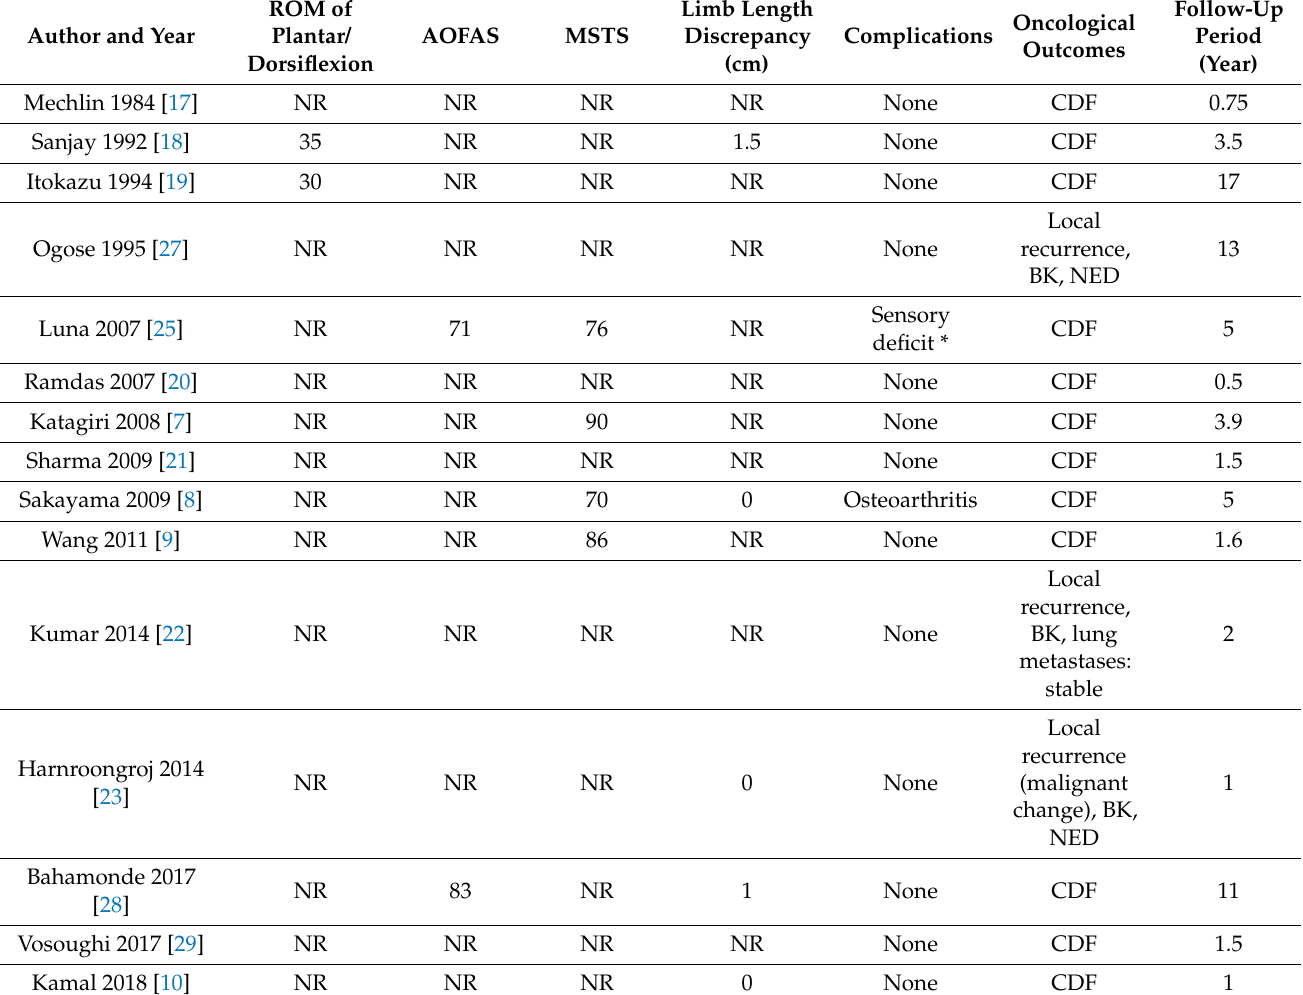
Table 2. Additional characteristics of included